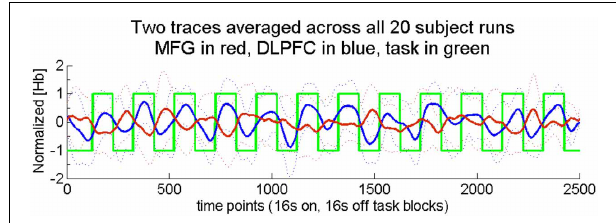
FIGURE 3 | Two across-region time traces averaged across all 20 runs. These traces illustrate filtered, normalized, and corrected (see fNIRS methods) hemoglobin concentration changes. For the purposes of this group average, all deoxygenated traces were first inverted. Truth labels are indicated by the green trace with task at + 1 and rest at − 1. The across-network correlation for the group was − 0.58. Task blocks were 16s each, with equal rest time. Dotted lines show ± one standard deviation for each time